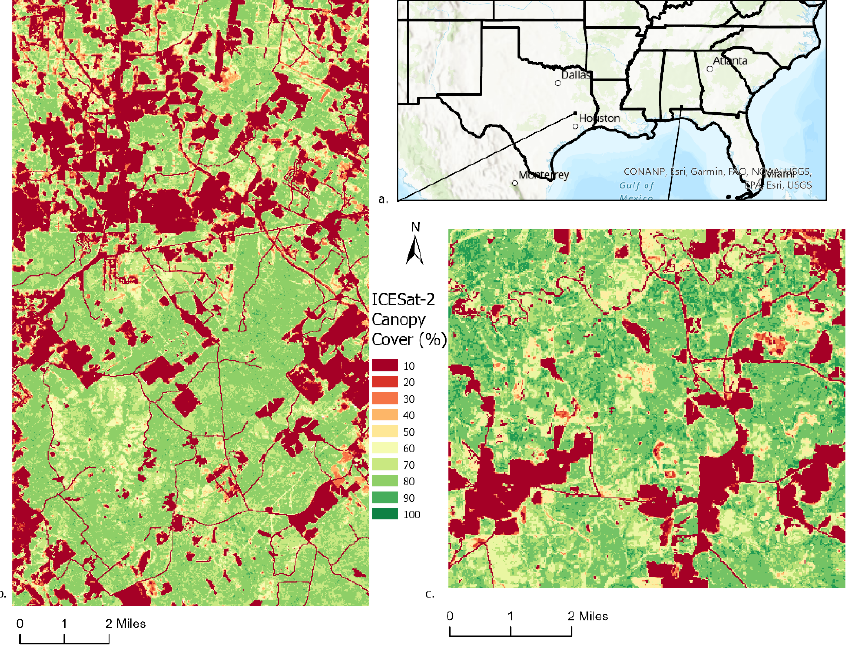
Figure 7. ICESat-2 canopy cover maps for two Southern US sites ( a ); SHNF ( b ) and SDFEC ( c ).